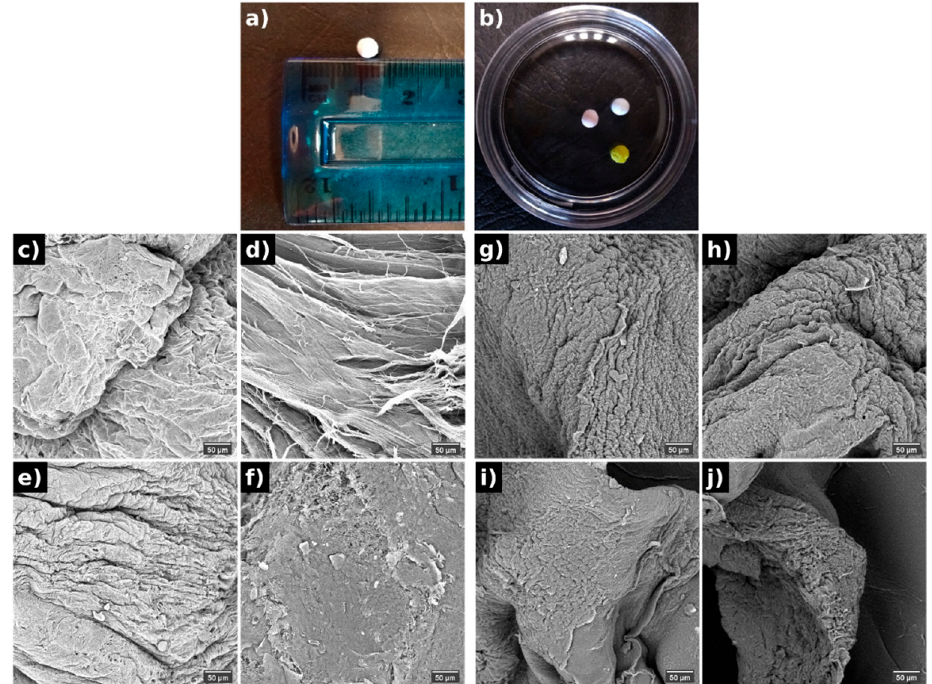
Figure 1. Macroscopic images of the PVA spheres ( a , b ) and its morphology evaluated by SEM from the surface ( c , e , g , i ) and internal ( d , f , h , j ) structure of ( c , d ) pure PVA, ( e , f ) doxo-PVA, ( g , h ) D14-PVA, ( i , j ) D14-doxo-PVA.